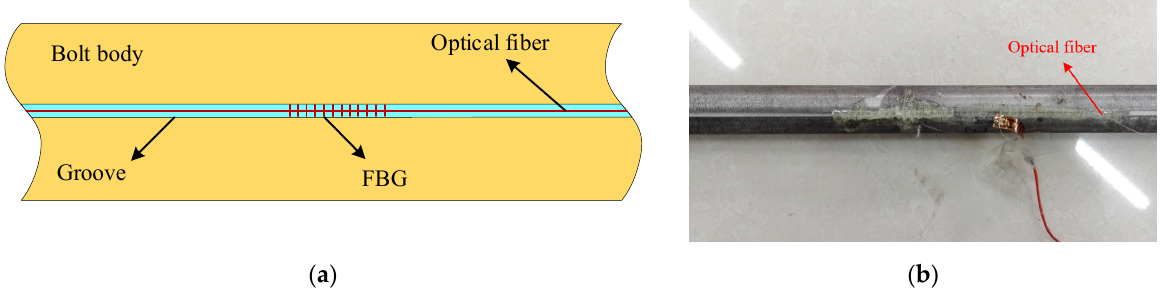
Figure 1. Structure schematic and photo of the existing FBG-FMB for laboratory test. ( a ) Structure schematic; ( b ) FBG-FMB Photo.